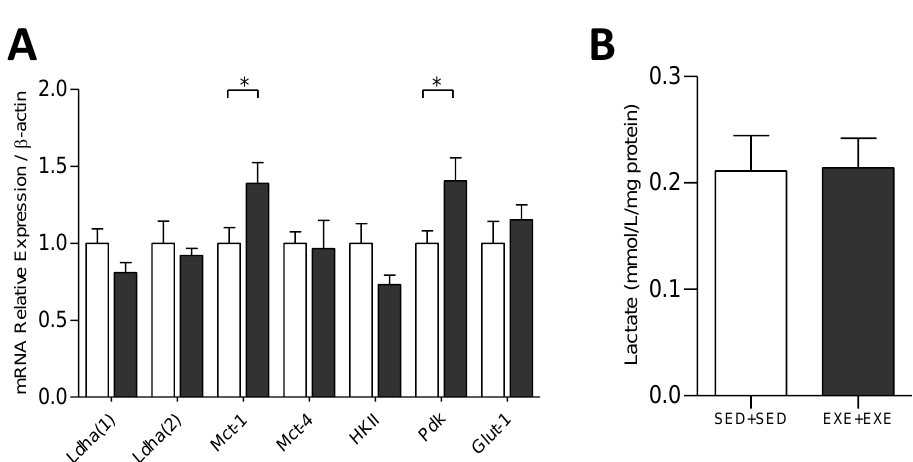
0 . 0 SE D + SE D EXE + EXE